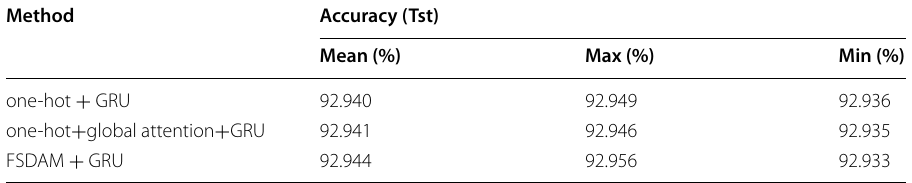
Table 14 Accuracy of different methods on UNSW-NB15 Method